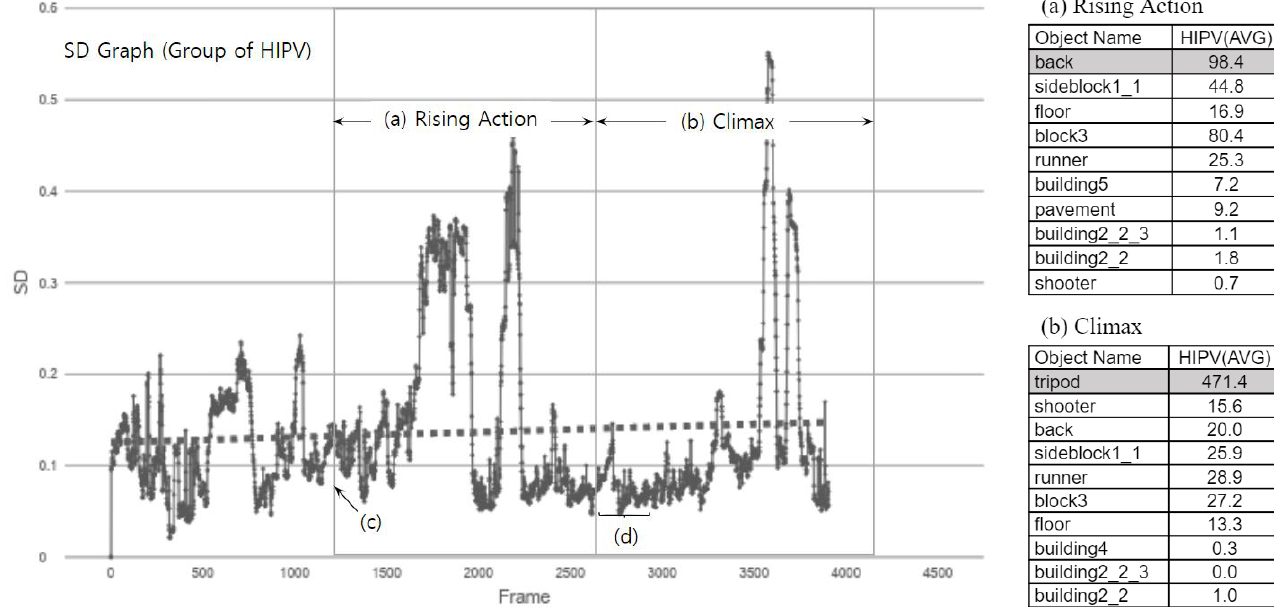
Figure 8. Male Group in the Rising Action and Climax (Standard Deviation ( left ) and Objects Most Seen ( right )). Along with the SD graphs that show the different levels of attention between the user types and genders, the elements that contributed to the participants’ attention were also investigated. The following is an analysis based on the rate of eyeball collisions for each type of LIPV, HIPV, male and female in the scenes, Rising Action and Climax. Particularly,